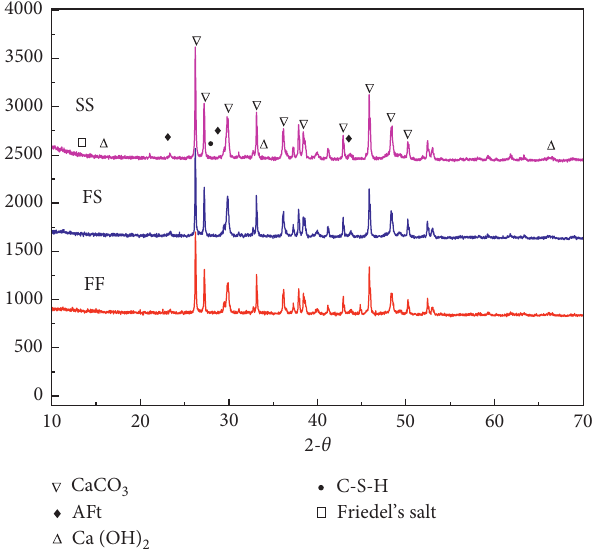
Figure 7: XRD pattern of 60-day cement-stabilized coral